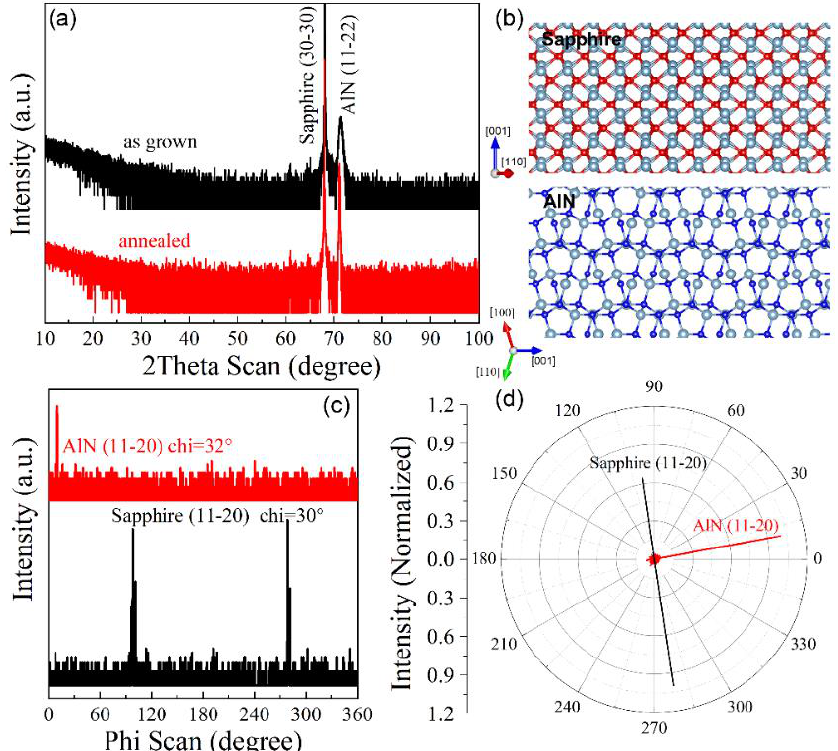
Figure 1. ( a ) XRD 2Theta-Omega scans of as-grown and annealed AlN samples on m plane sapphire along the out-of-plane direction; ( b ) The plan-view of crystal-lattice along the sapphire [101̅0] and AlN [112̅2] directions; XRD ( c ) Phi-dependent and ( d ) polar scans of sapphire (11-20) and AlN (11-20) planes when the chi angle is 32° and 30°, respectively. The thickness and annealing duration of the measured samples are 500 nm and 5 h, respectively.